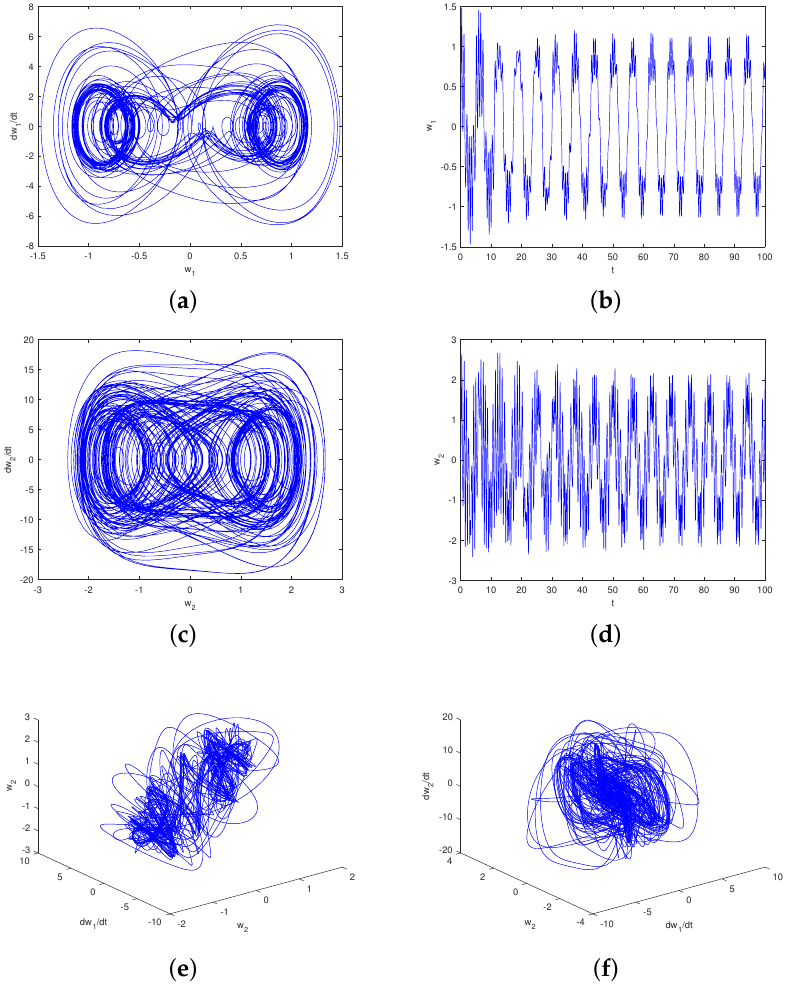
Figure 3. The phase portraits and waveforms of the sandwich plate with truss core when µ = 0.1 ) ; ( b ) the waveform on plane ( t , w ) ; ( c ) the and f = 50: ( a ) the phase portrait on plane ( w 1 , dw 1 1 dt ) ; ( d ) the waveform on plane ( t , w ) ; ( e ) the phase portraits in phase portrait on plane ( w 2 , dw 2 2 dt the three-dimensional space ( w 1 , dw 1 , w 2 ) ; ( f ) the phase portraits in the three-dimensional space dt ( dw 1 ) , w 2 , dw 2 dt dt